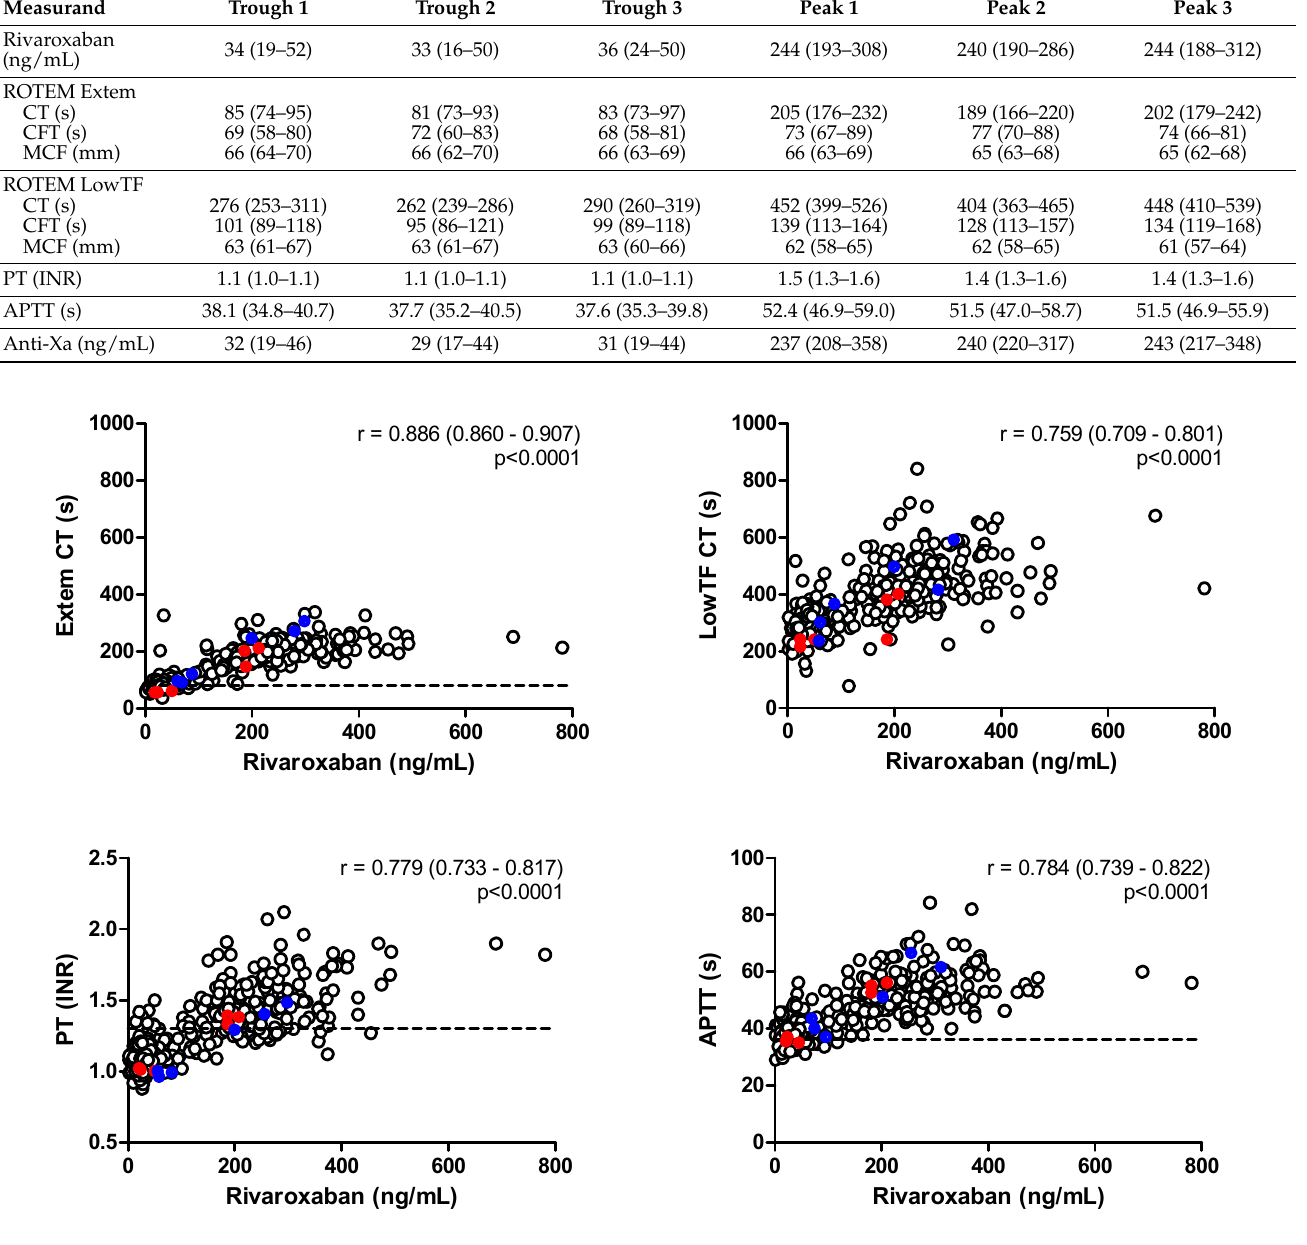
Figure 1. Correlation between rivaroxaban concentration and ROTEM Extem CT, ROTEM LowTF, PT, and APTT. Pearson’s correlation coefficient is given with the 95% confidence interval and statistical significance. Dotted lines represent the upper reference value. Results from patients receiving antiplatelet therapy are shown in color (red for acetylsalicylic acid and blue for clopidogrel). Intra- (CV I ) and interindividual (CV G ) biological variations were calculated separately 1. for trough and peak values for all the measured variables and are shown in Table 3. As expected, interindividual variations were higher than intraindividual variations. The highest CV G was observed for anti-Xa (87.7 %) and rivaroxaban concentration (80.0 %). The lowest CVs were observed for ROTEM Extem MCF, which did not correlate with the rivaroxaban